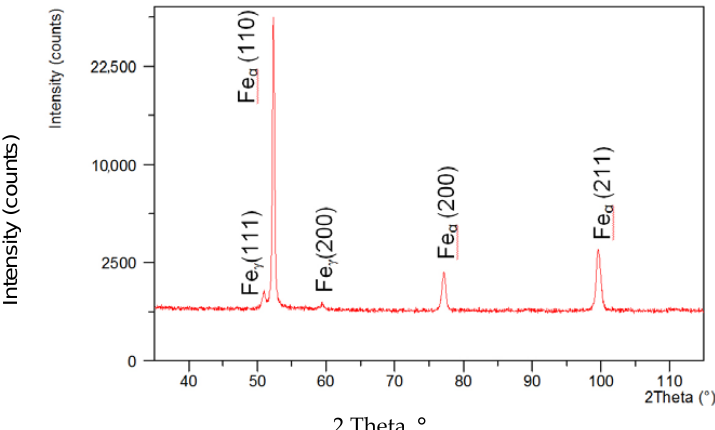
Figure 12. X-ray diffraction of the butt weld made in steel S700 MC.